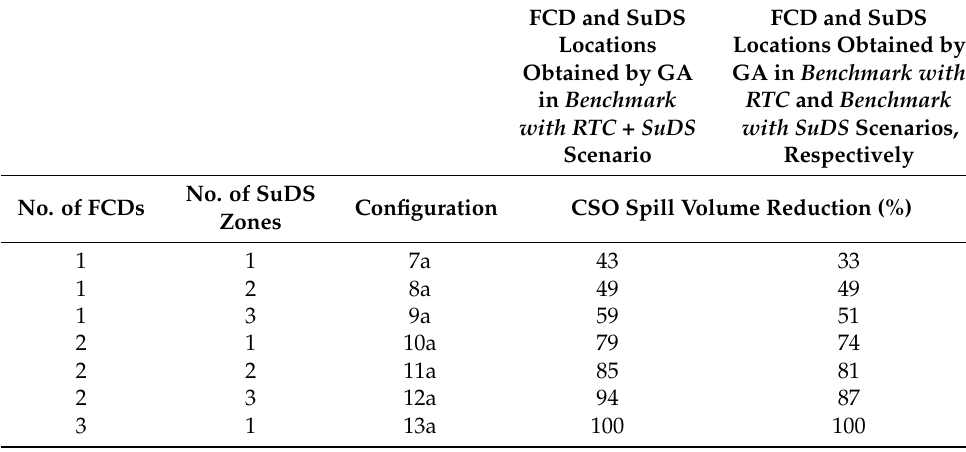
FCD and SuDS FCD and SuDS Locations Obtained by Locations GA in Benchmark with Obtained by GA RTC and Benchmark in Benchmark with SuDS Scenarios, with RTC + SuDS Scenario